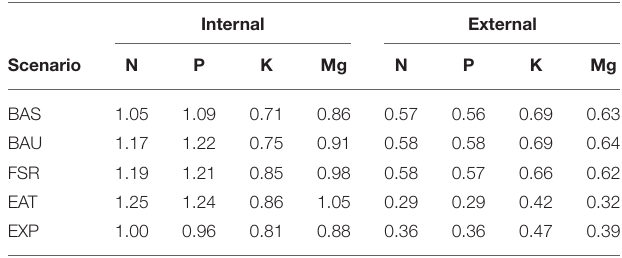
TABLE 3 | System openness across scenarios, internal and external to the Okanagan. Internal External Scenario